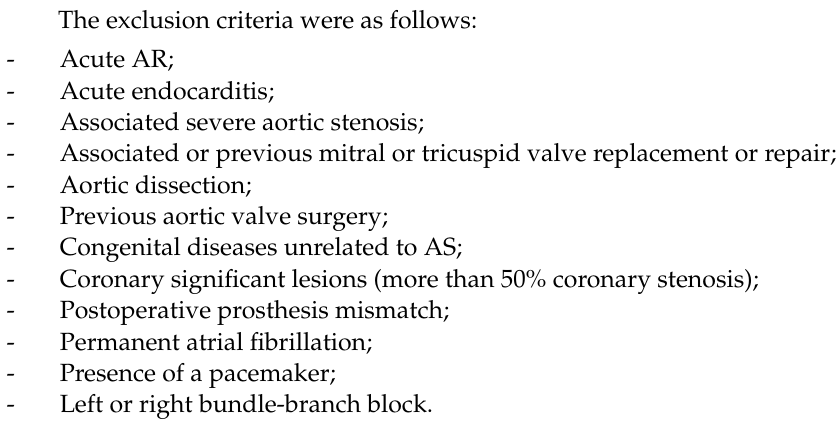
Figure 1. Study group structure depending on LV systolic and diastolic performance.